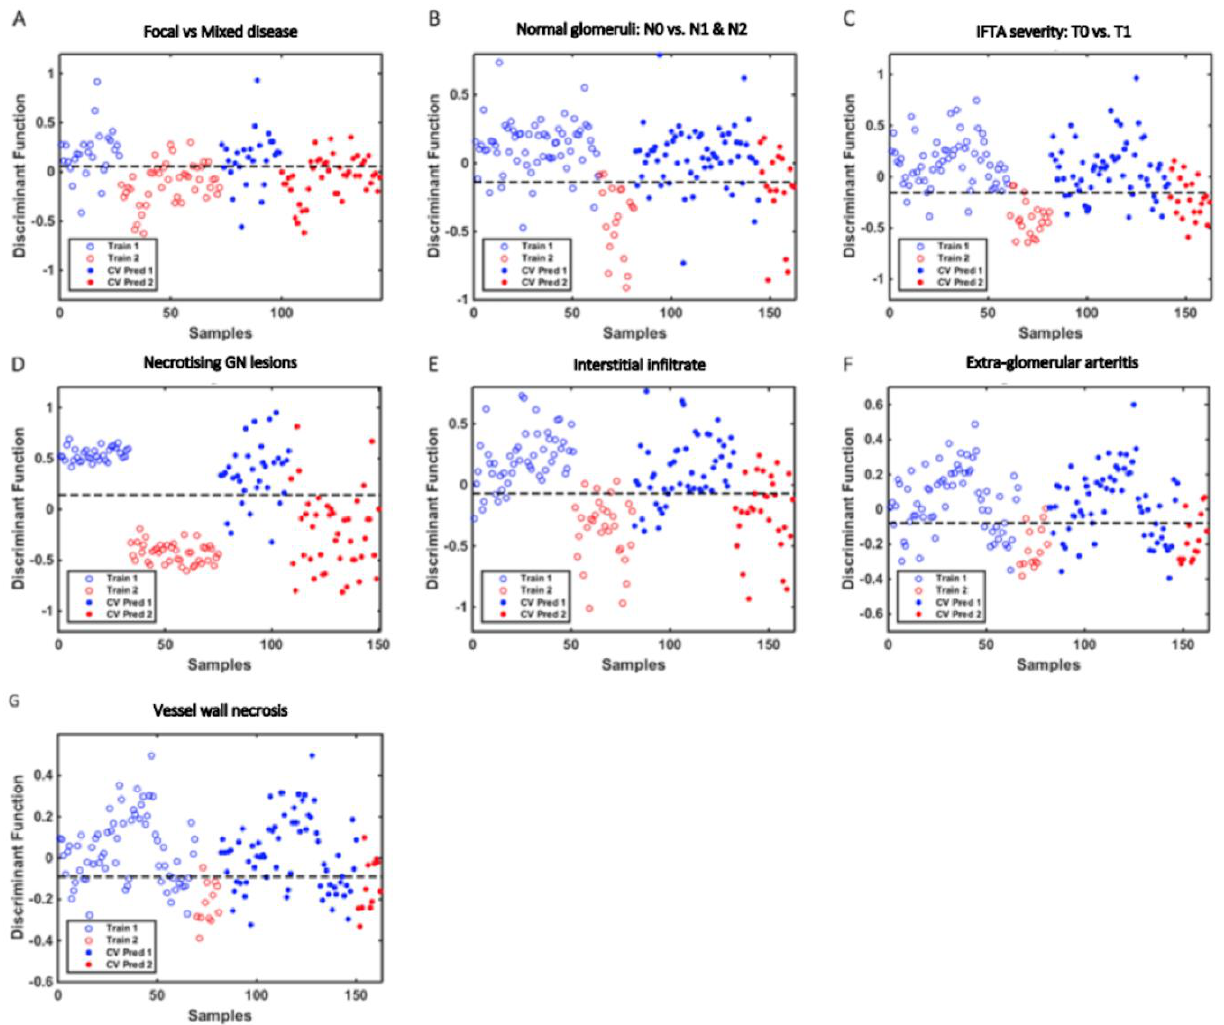
Figure 2. PLS-DA discriminant function graphs for the classification of histological data using spectral data from all tissue samples with corresponding receiver operating characteristic curve data. Train 1 and Train 2 represent training sample data for each histological group. CV Pred 1 and CV Pred 2 represent test sample data for each histological group analysed by the cross-validation (CV) prediction process: ( A ) Mixed vs. focal disease (train 1 & CV Pred 1 vs. train 2 & CV